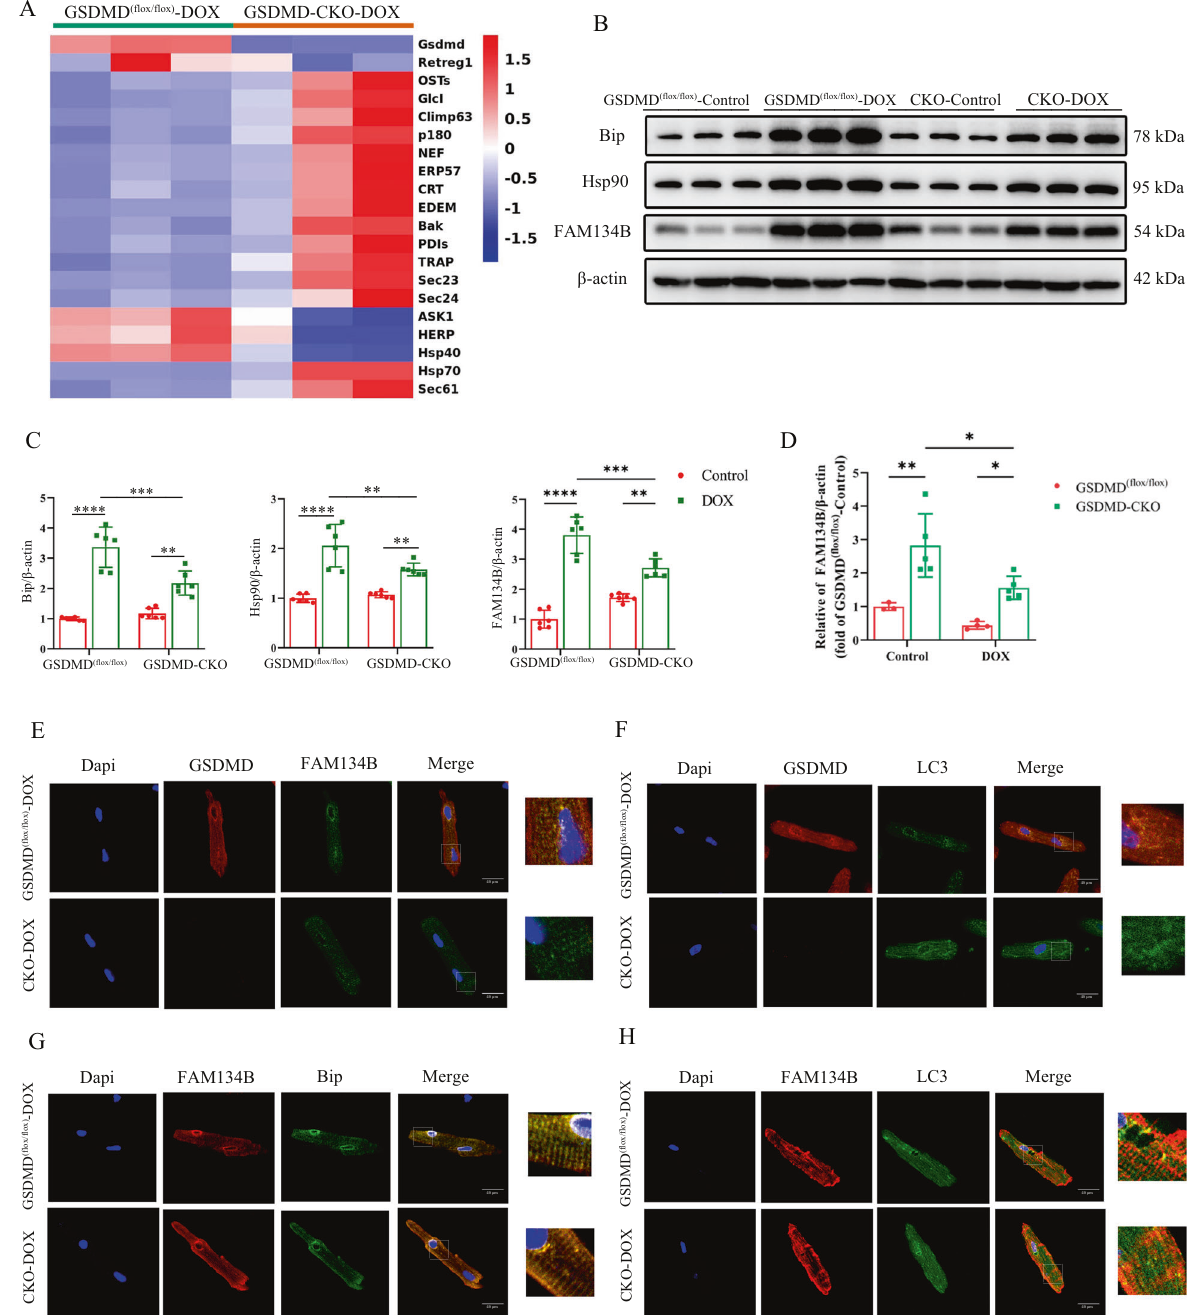
Fig. 6 RNA-seq revealed potential target genes of GSDMD. A Heatmaps show differentially expressed genes between GSDMD ( fl ox/ fl ox) -DOX and GSDMD-CKO-DOX mice based on RNA-seq data. B , C Western blot analysis of endoplasmic reticulum related genes, Bip, Hsp90, and FAM134B. Representative immunoblots and quanti fi cations are shown. N = 6 per group. D q-PCR analysis of FAM134B in GSDMD ( fl ox/ fl ox) and GSDMD-CKO hearts. N = 3 – 5 per group. E – H Representative GSDMD and FAM134B expression, GSDMD and LC3 expression, FAM134B and Bip expression, FAM134B and LC3 expression, and colocalization in cardiomyocytes as shown by immuno fl uorescence analysis in adult mice hearts after DOX treatment. Scale bar, 40 μ m. Data are depicted as the mean ± SEM. Statistical signi fi cance was determined by one-way and two-way ANOVA with a post hoc Holm – Sidak test, ns not signi fi cant; * P < 0.05; ** P < 0.01; *** P < 0.001; **** P < caspase-11/GSDMD signaling pathway. Accordingly, GSDMD-KO and AAV9-GSDMD-OE mice were obtained to explore the speci fi c underlying mechanism. We observed that GSDMD deletion alleviated DIC and that mortality and cardiac injury increased cardiomyocyte-speci fi c GSDMD KO exacerbated apoptosis after GSDMD overexpression in mice. Although cardiomyocytes and DIC. account for a large proportion of the heart tissue, which is